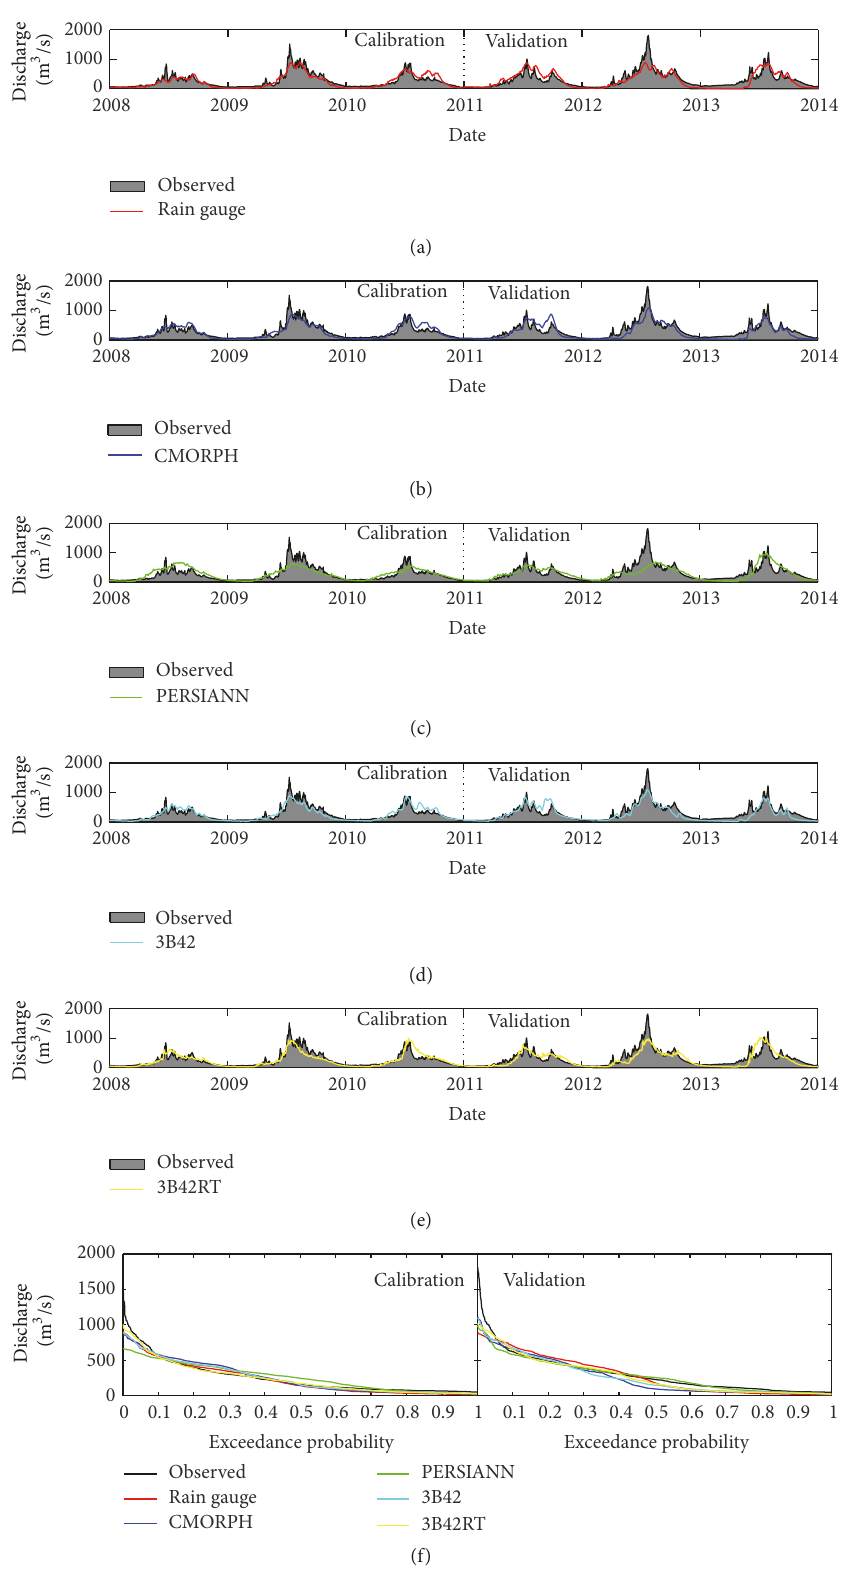
Figure 10: As in Figure 9, but HEC-HMS model was recalibrated and validated with each precipitation dataset as inputs during the period from 2008 to